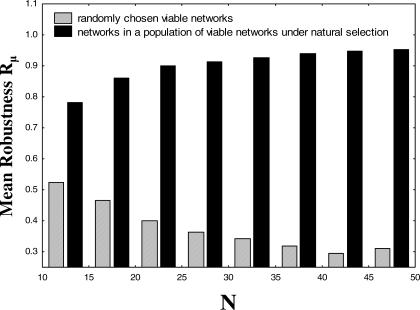
Natural Selection for Viability Dramatically Increases RobustnessThe horizontal axis shows the number of genes per network. Black bars on the vertical axis show the mean mutational robustness
R̄
μ for populations under viability selection with PNμ ≫ 1, and grey bars show the mean mutational robustness
R̄
μ for a population with PNμ ≪ 1, in which selection for increased robustness is ineffective, and, thus, sampling of the metagraph is uniform (M ≈ 0.25 N2, d = 0.5).